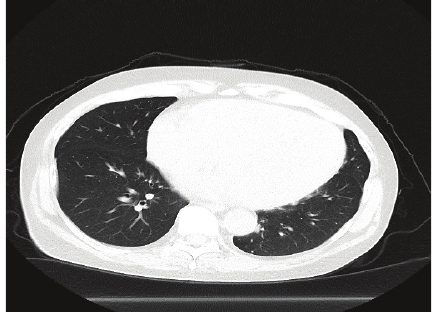
Figure 2: CT showing lung lesion before Vemurafenib.